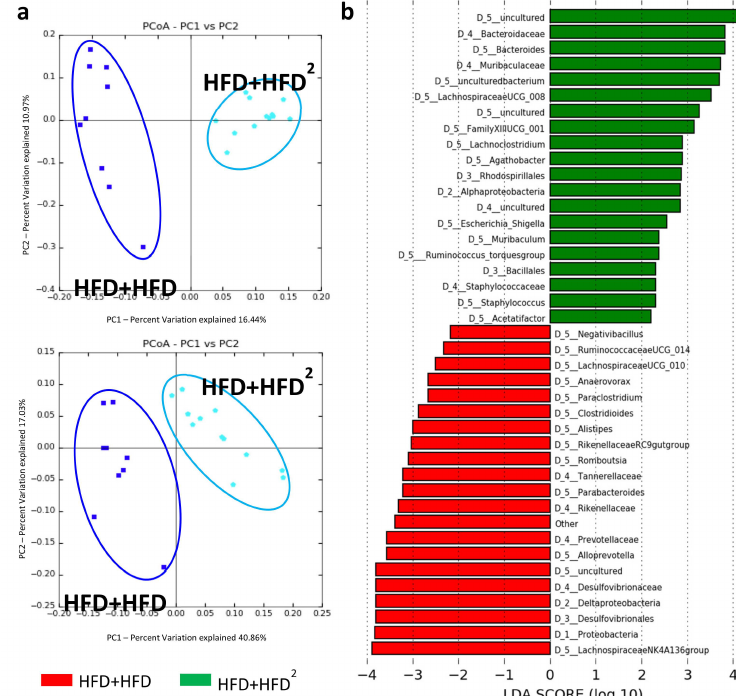
Figure 4. Modification of the IM of HFD mice following pectin supplementation. Mice were fed an HFD for 16 weeks and received pectin supplementation (2%) from week 16 to week 24 as curative treatment (HFD+HFD 2 ) versus mice not receiving pectin (HFD + HFD): ( a ) unweighted (left, p = 0.02) and weighted (right, p = 0.01) Unifrac distances showing differences in IM composition and relative OTU abundance between HFD + HFD (dark blue) and HFD + HFD 2 (light blue) mice. ( b ) LDA Effect Size (LEfSe) for the taxa enriched in HFD + HFD (red) or HFD + HFD 2 (green) mice. Only taxa with a LDA score >2 and p < 0.05, determined by the Wilcoxon signed rank test, are shown. Data represent analysis of the IM of 9 or 12